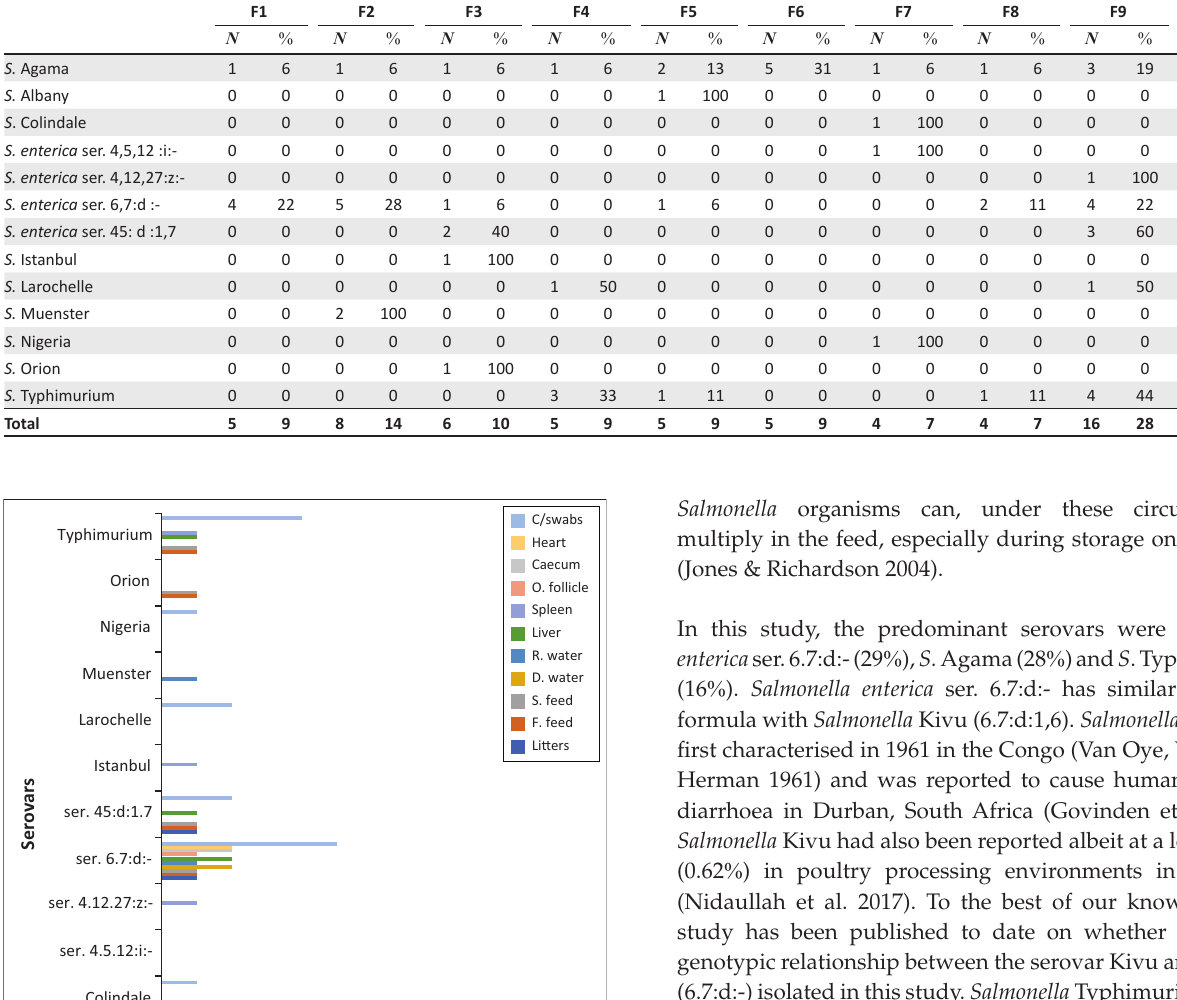
TABLE 4: Occurrence of Salmonella serovars in different poultry farms in Kwara State. Serovars